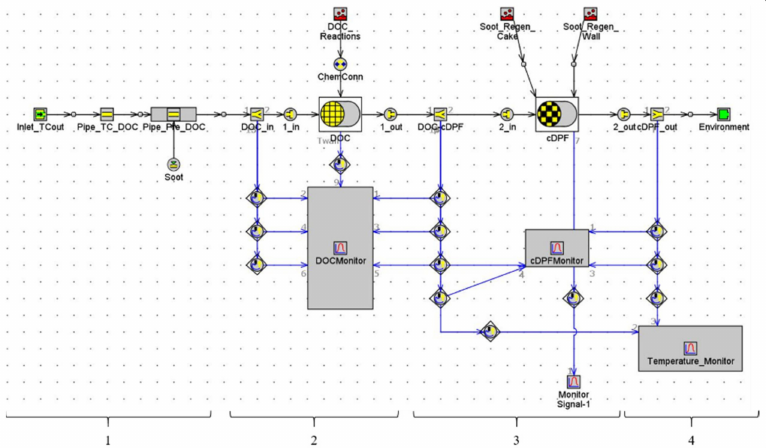
Figure 7. Schematic diagram of the DOC + DPF simulation model. 1. Soot inlet and its pipeline module. 2. DOC_Reactions, DOC and DOCMonitor modules. 3. Soot_Regen_Cake, Soot_Regen_Wall, cDPF and cDPFMonitor modules. 4. Temperature Monitor module.